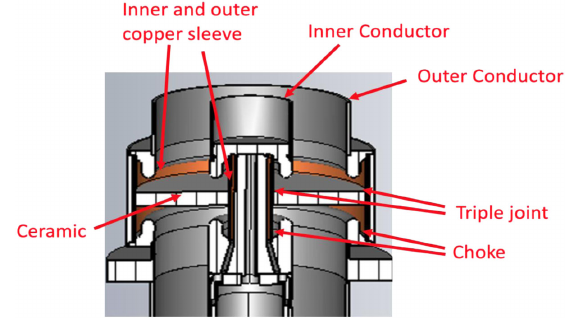
FIG. 3. Choke structure rf